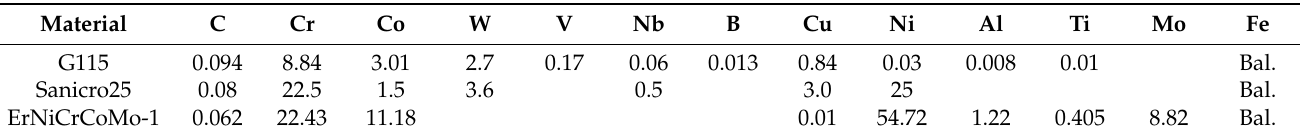
Table 1. Chemical composition of the WM and BMs